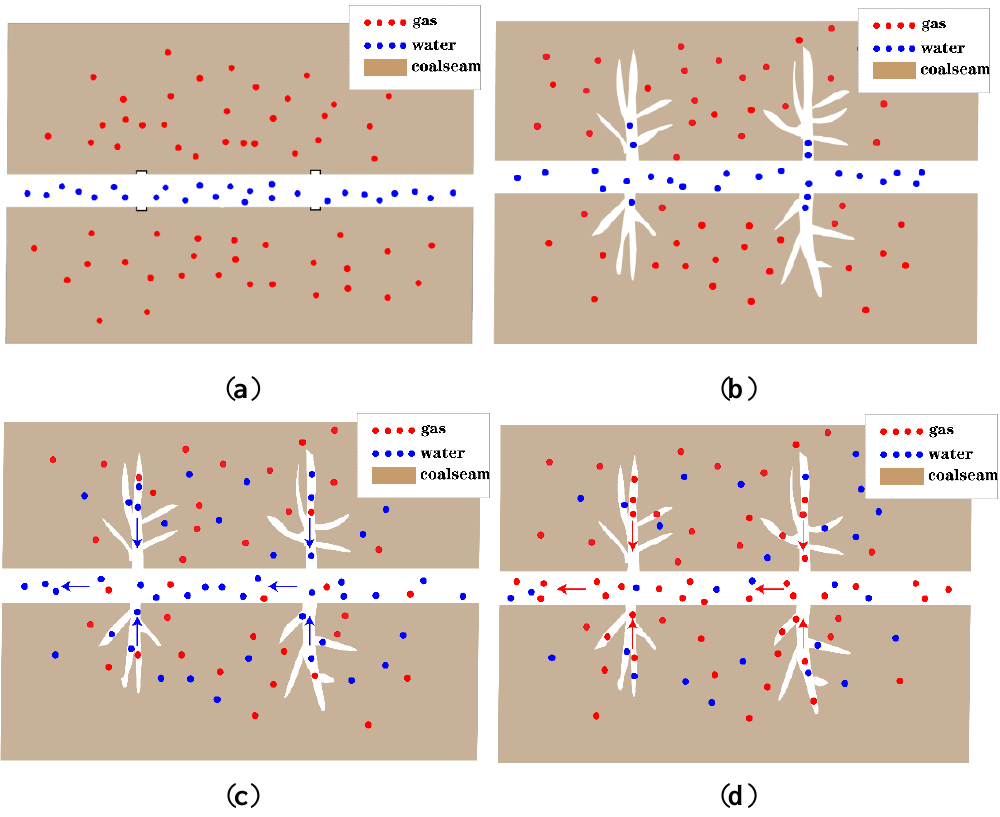
Figure 1. Schematic diagram of the reservoir (a) Initial and rising pressure stages; (b) Hydraulic fracturing stage; (c) Water drainage stage; (d) Gas production stage.